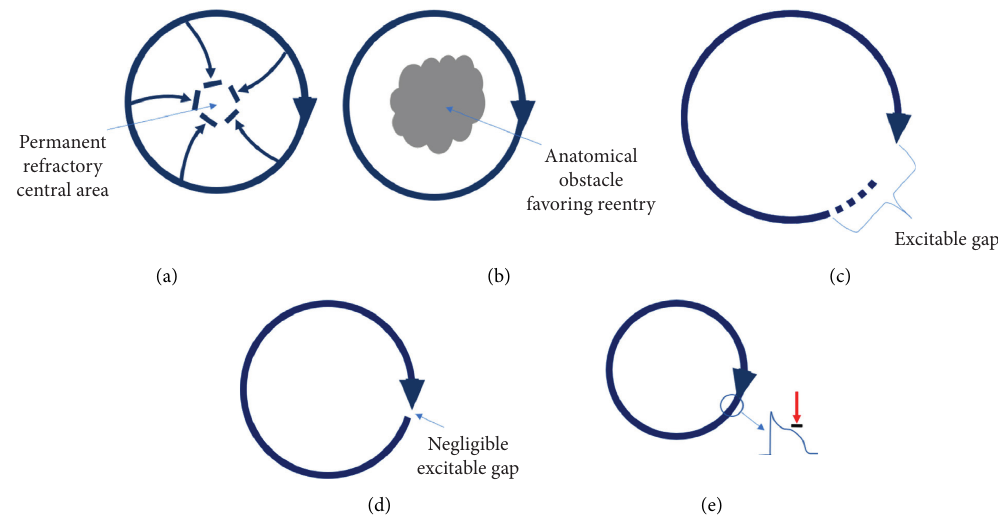
Figure 1: (a) Leading circle reentry. The impulse spreads to the inside of the circuit continuously, making it permanently unexcitable. (b) Typical reentrant circuit around an anatomical barrier. (c) Reentrant circuit with the excitation gap. (d) Reentrant circuit without the excitation gap. (e) Unsustainable reentrant circuit as its frontal part collides with its nonexcitable terminal